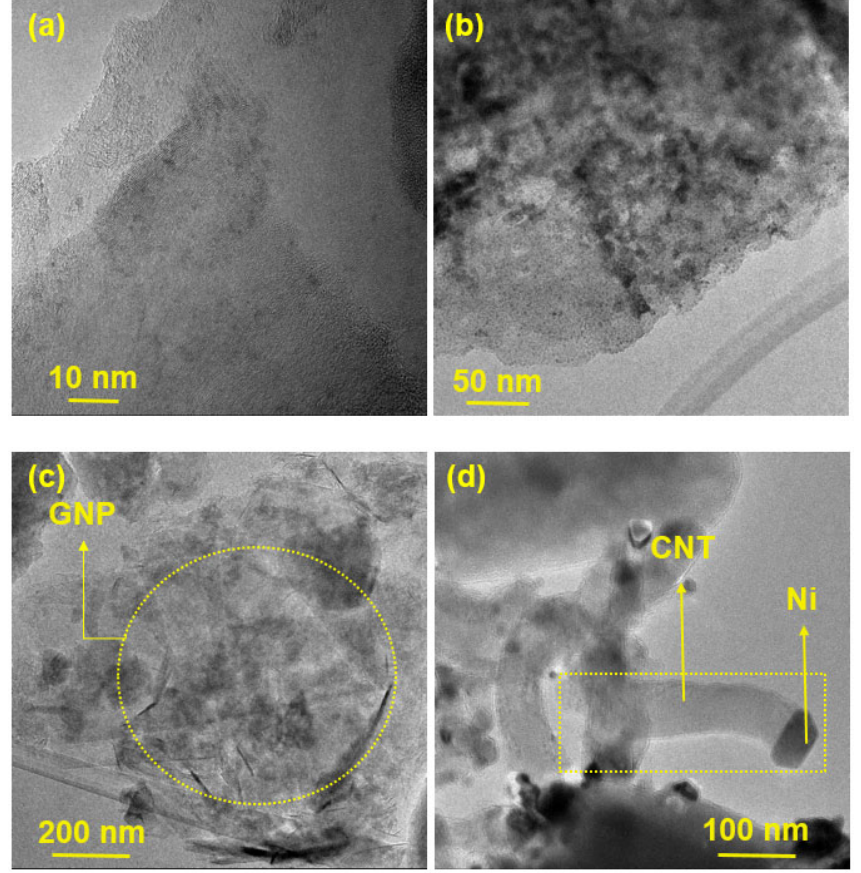
Figure 4. TEM images obtained on ( a – c ) GNP/Ni ‐ W ‐ ZY30 and ( d ) CNT/Ni ‐ ZY30 catalysts.